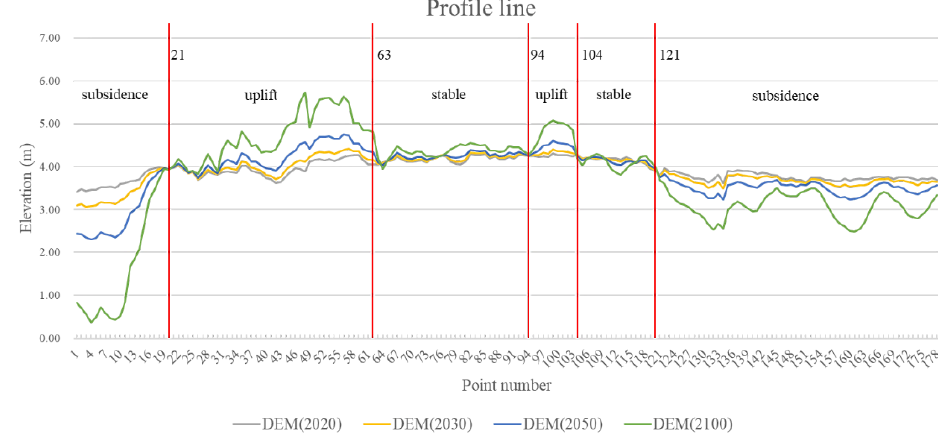
Figure 20. Profile line of Gudong Dam in the years 2020, 2030, 2050 and 2100, which showed the trend of the dam over time. The vertical axis represents the elevation, and the point number of the horizontal axis represents a segment number from north to south.